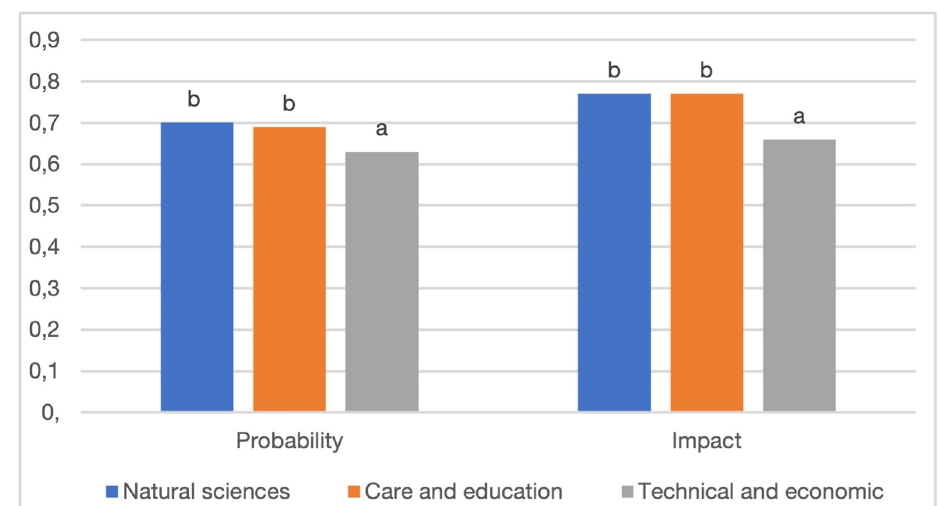
Fig 2. Differences in the assessment of the probability and the potential impact of environmental risks between students of different fields of study. Note : The letters mark significant differences between the fields of study (based on the Tukey test).